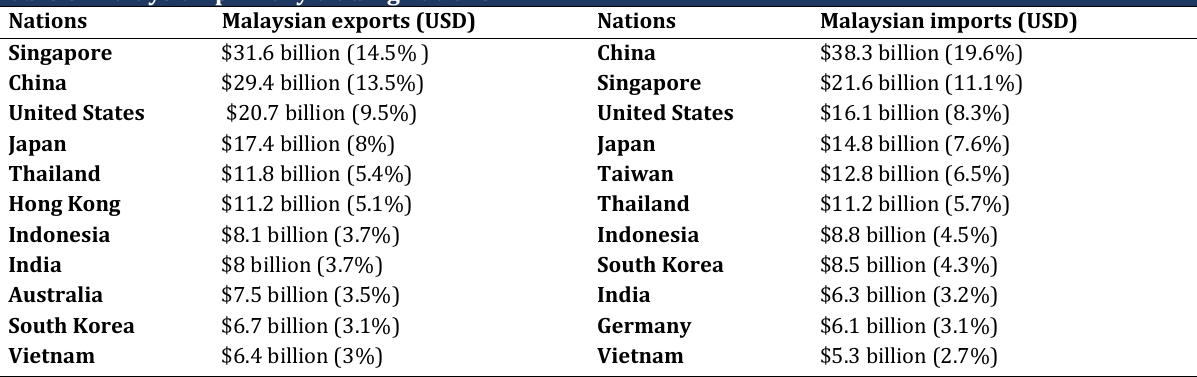
Table 3: Malaysian primary trading nations Nations Malaysian exports